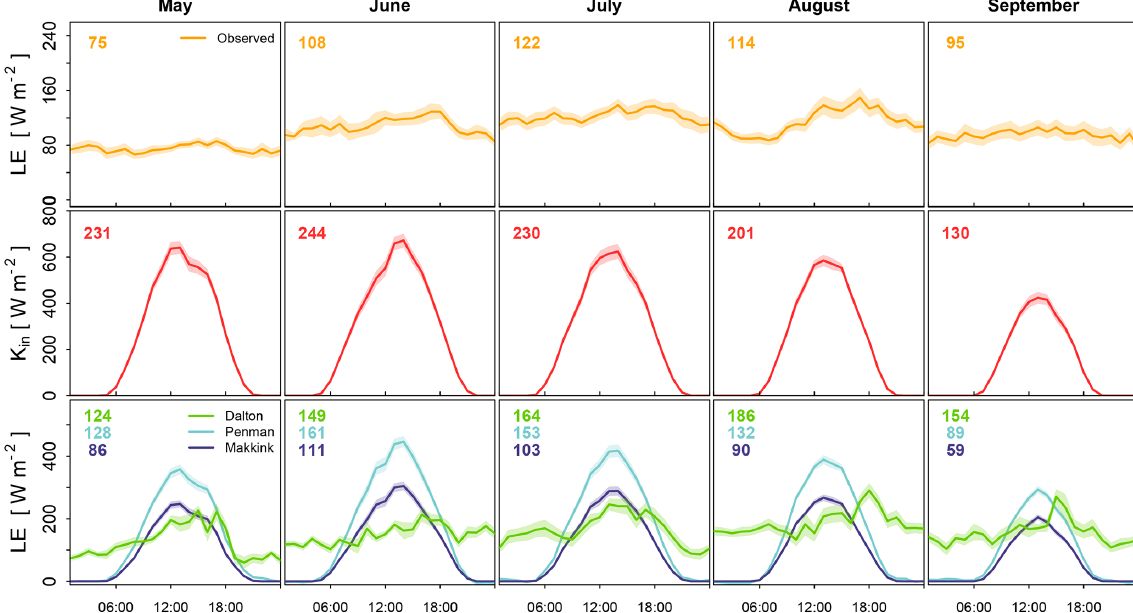
Figure 3. An illustration of the decoupling in Stavoren in 2019 between the monthly average diurnal cycles of observed latent heat flux (top panels) and global radiation (middle panels), with the latter forming the basis of the frequently used evaporation models of Penman (1948) and Makkink (1957). These models are shown together with the model of Dalton (1802) in the bottom panels. Note that some variables included in the evaporation models are measured at heights above the 2m that is prescribed (see Eqs. 6–12). Additionally, all three models are generally used on a daily basis, but they are presented here to show the underlying daily cycle. The shaded area represents the uncertainty, which is defined as the standard deviation divided by the square root of the number of observations. Average daily means of the respective variables are indicated by the number in the top left of each panel and display the average course over the summer period.